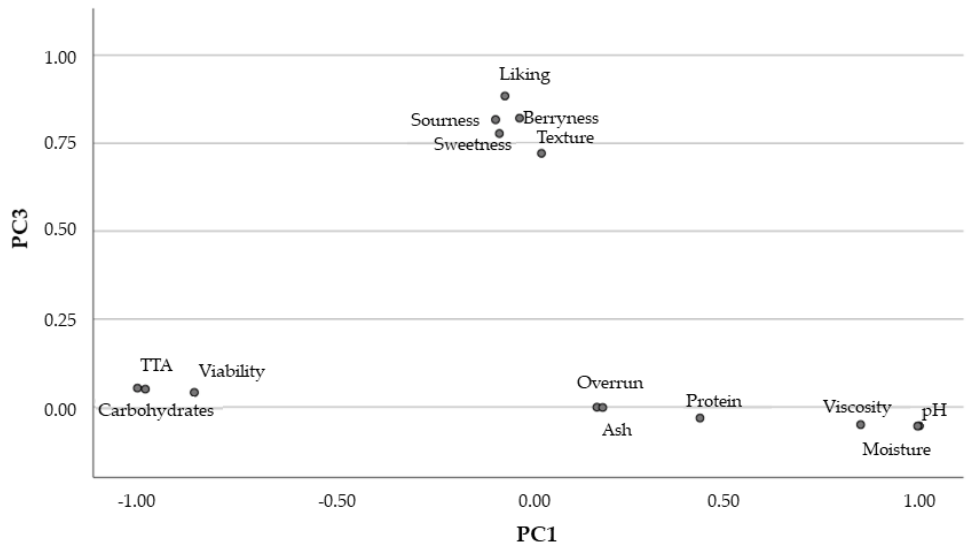
Figure A1. Loadings of the Principal components 1 and 3 given by the Principal Component Analysis (PCA).